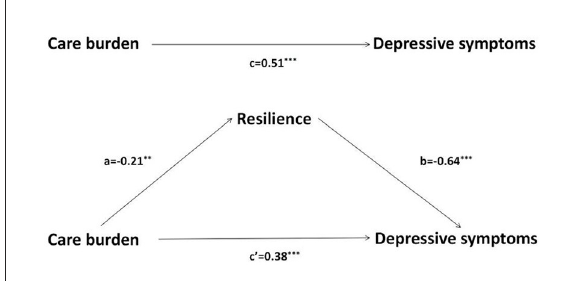
FIGURE1 The mediating effects of resilience between care burden and depressive symptoms. ** p < 0.01, *** p < 0.001. Standardized regression coefficient for the mediation model. (a) is the effect of care burden on resilience, (b) is the effect of resilience on depressive symptoms, (c) is the total effect of care burden on depressive symptoms, (c’) is the direct effect of care burden on depressive symptoms (15).